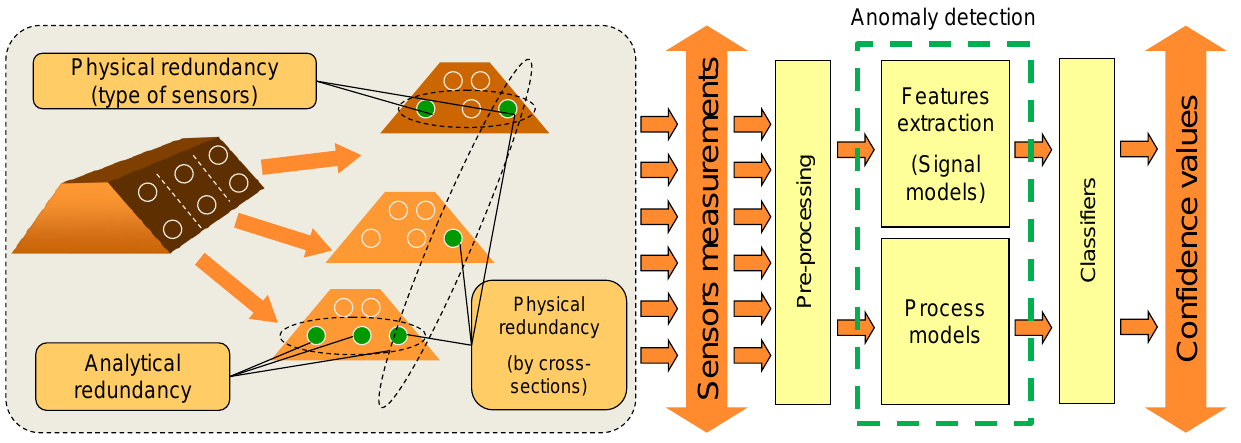
Figure 2. Anomaly detection